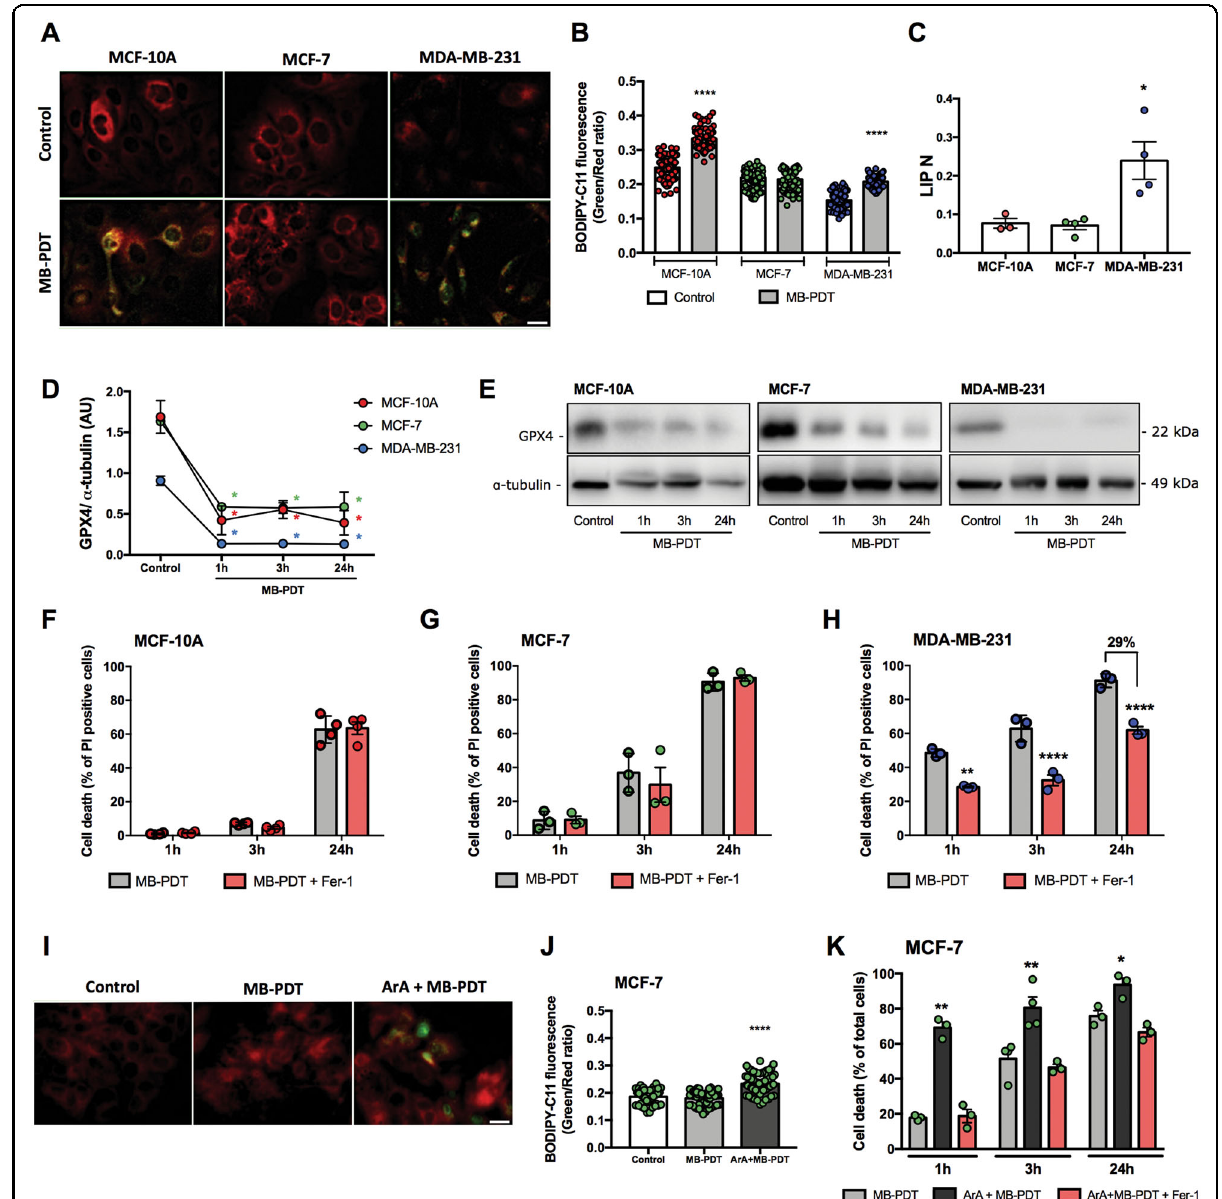
Fig. 2 MB-PDT induces ferroptosis in PUFA- and LIP-enriched cells. A Representative images of lipid peroxidation in cells submitted or not to MB-PDT. Reduced (red) or oxidized (green) BODIPY-C11. B Graphical representation of the quanti fi cation of the oxidized/reduced BODIPY-C11 ratio/ cell. Each dot represents an individual cell. A minimum of 100 cells was analyzed/experiment. **** p < 0.0001 vs. control of each cell line. C Intracellular labile iron poll (LIP), normalized by the total intracellular calcein incorporated per cell (LIPN). * p < 0.05 vs. MCF-10A. D GPX4 protein quanti fi cation in cells after 1, 3, and 24 h of being submitted or not to MB-PDT (Control). * p < 0.05 vs. control of each cell line. E Representative images of western blottings of GPX4 of BC after being treated or not with MB-PDT, as indicated. Middle panels show the percentage of cell death after MB-PDT (1, 3, or 24 h) in cells pretreated or not with Fer-1: F MCF-10A, G MCF-7, and H MDA-MB-231. ** p < 0.005 vs. MB-PDT; **** p < 0.0001 vs. MB-PDT. I Representative images of lipid peroxidation in MCF-7 cells pre-incubated or not with ArA before being submitted or not to MB-PDT. J Corresponding quanti fi cation (as described in item B ) of oxidized/reduced BODIPY-C11 ratio in MCF-7 cells. **** p < 0.0001 vs. control. K Cell death percentage of MCF-7 cells pretreated or not with Fer-1 and/or ArA as indicated after 1, 3, or 24 h of photo-oxidation induction. ** p < 0.005 vs. MB-PDT; * p < 0.05 vs. MB-PDT. n ≥ 3 independent experiments. Dot color representation: MCF-10A in red, MCF-7 in green, and MDA-MB-231 in blue. Results are presented as mean ± SEM.